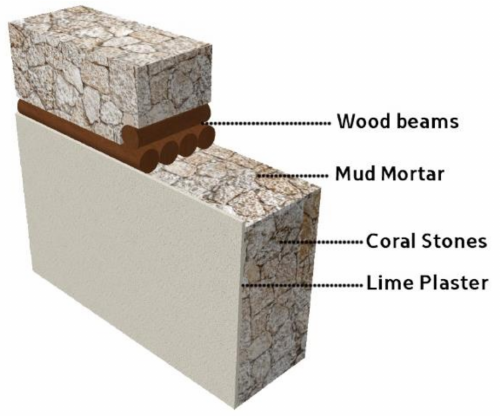
Figure 9. Cross-section view of the external